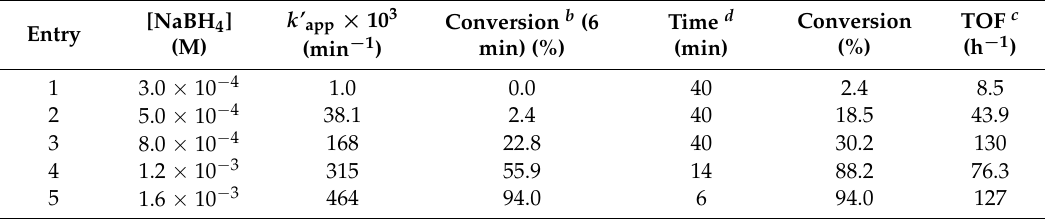
Figure 9. Plot of apparent rate constant k’ app obtained from Table 2 versus concentration of NaBH 4 (data from Table 2). Table 2. Reduction of 4-NP to 4-AP with variable concentrations of NaBH 4 a .